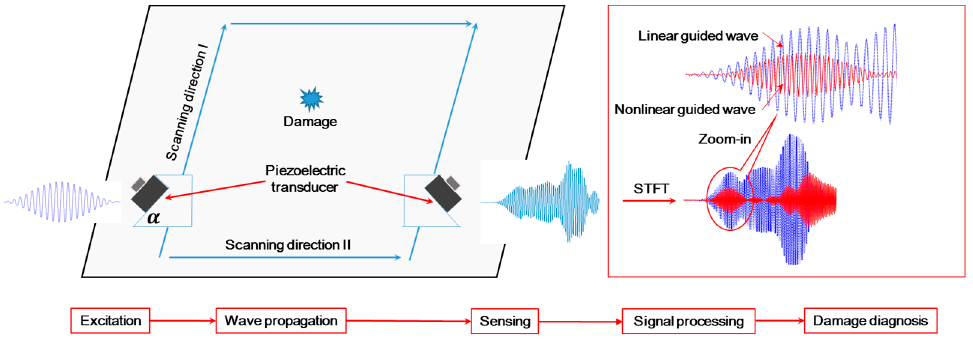
Figure 14. Schematic of linear/nonlinear guided wave-based damage characterization.